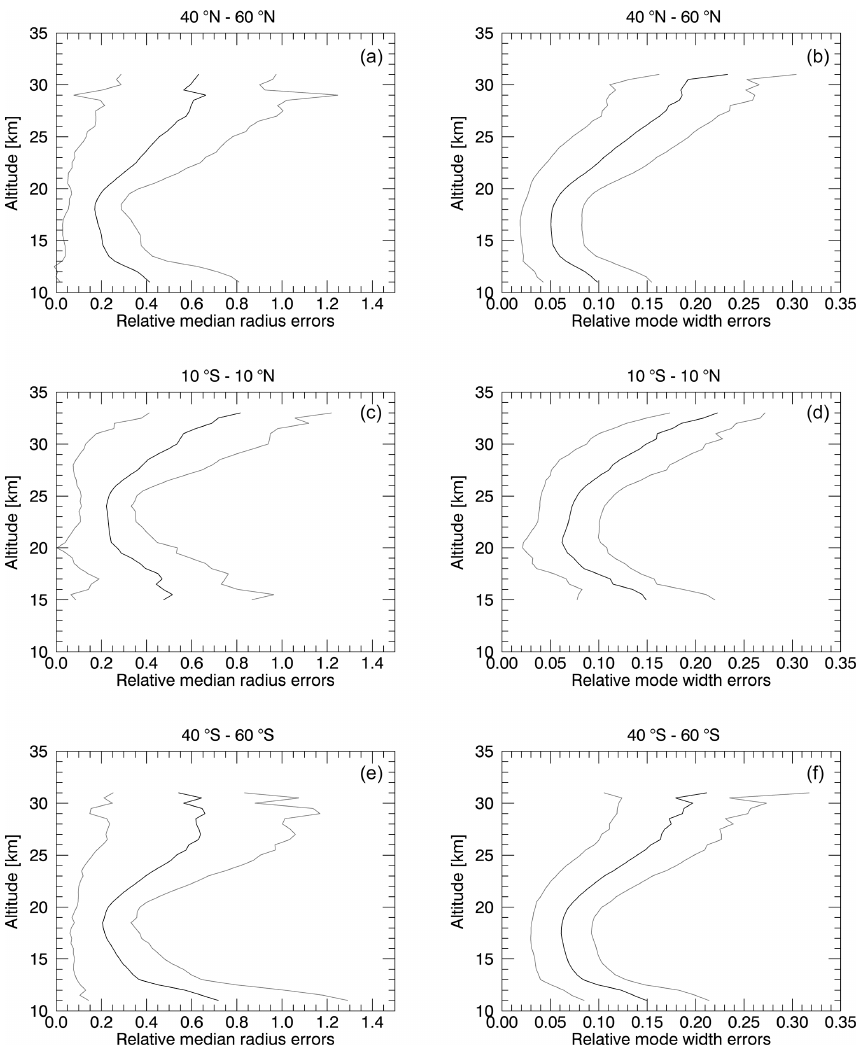
Figure 7. Relative total errors of median radius (a, c, e) and mode width (b, d, f) averaged over all measurements between June 2017 and December 2019 shown as black line. Averages are shown between 40 and 60 ◦ N (a, b) , 10 ◦ S and 10 ◦ N (c, d) , and 40 and 60 ◦ S (e, f) . Grey lines indicate the standard deviation.